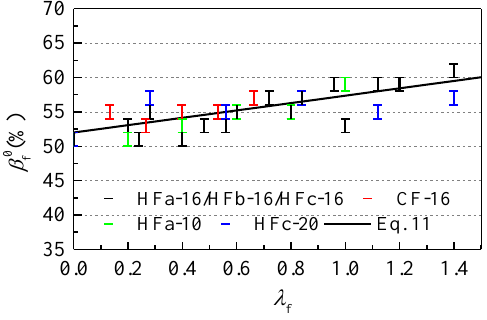
Figure 6. The relationship between the rational sand ratio β 0